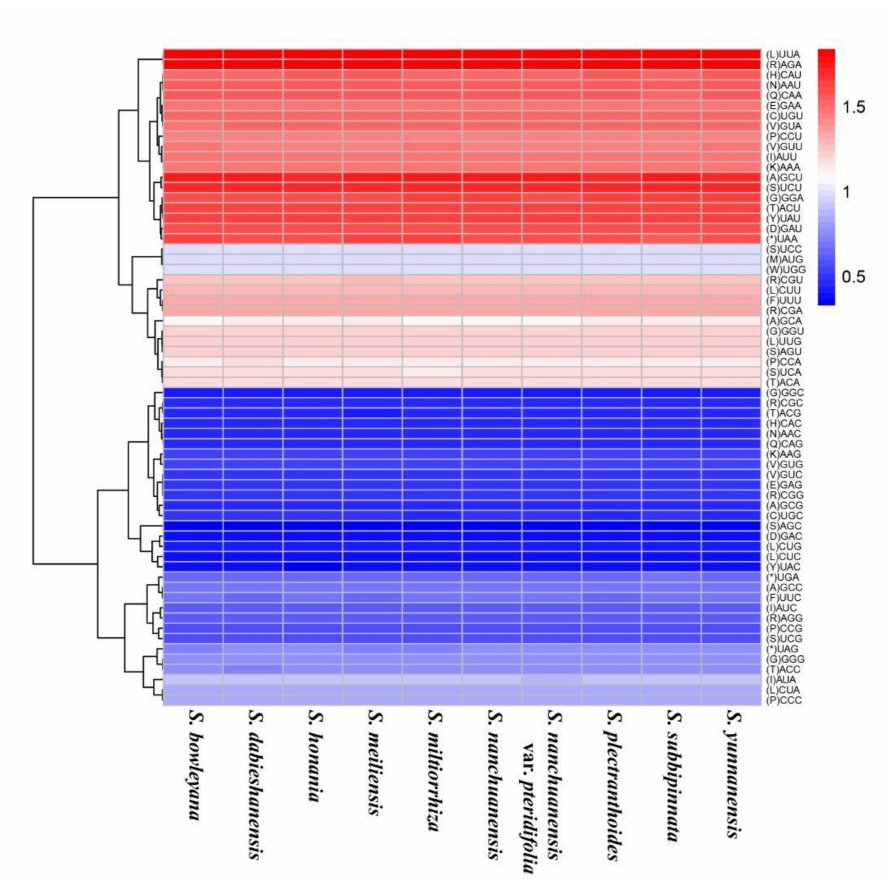
Figure 3. Heatmap of codon distribution of all protein-coding genes from 10 taxa of Salvia sect. Drymosphace . Higher red values indicate higher RSCU values, and lower blue values indicate lower RSCU